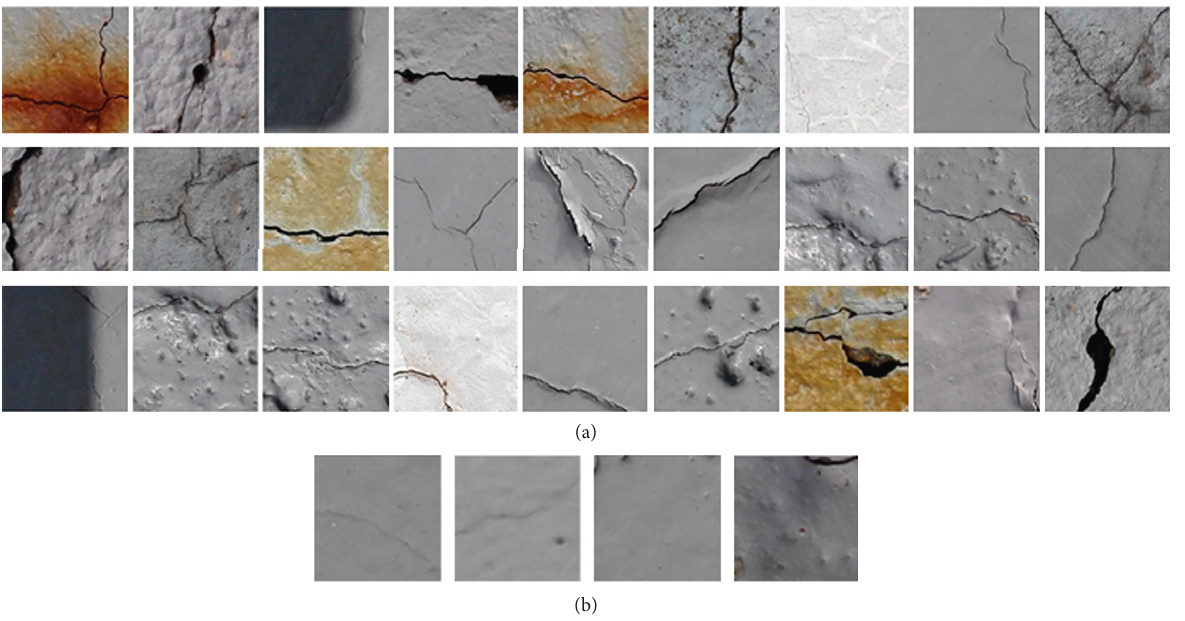
Figure 6: Cropped images: (a) images with cracks used for building database; (b) removed